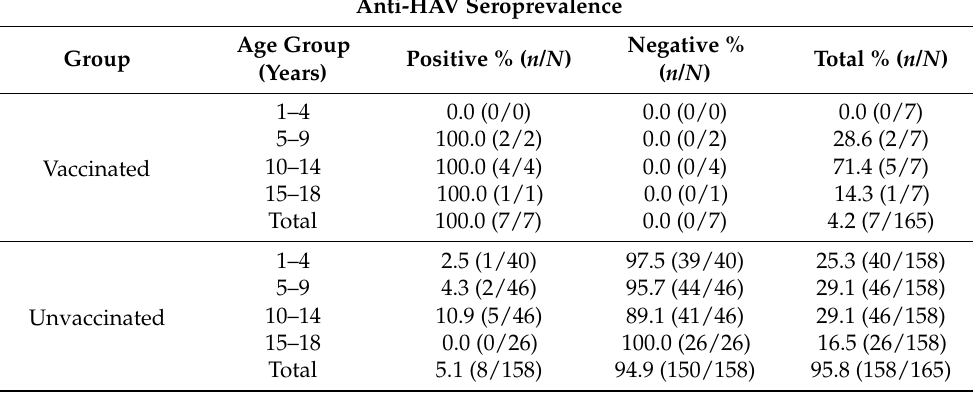
Table 5. Vaccination status of the enrolled subjects related to the serological result ( n / N : number of subjects/total).